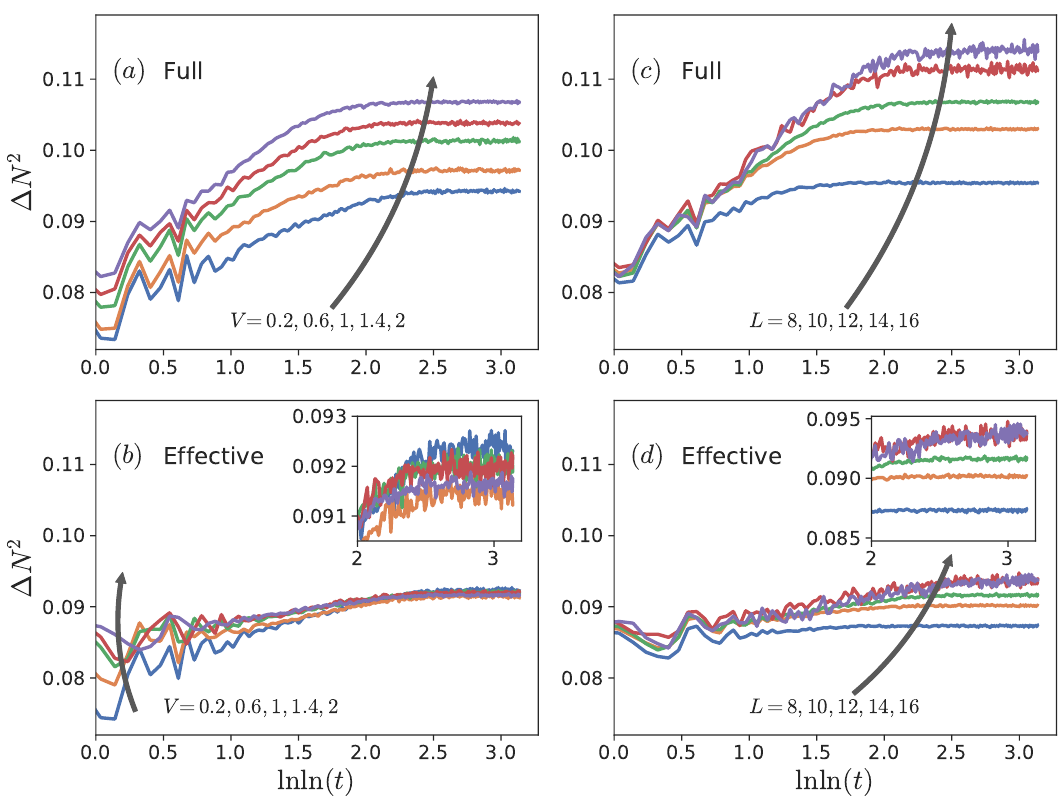
Figure 6: ∆ N 2 ( t ) for the full and effective models for different interaction strength V and system sizes L . For L = 8,10 200000 samples were used, for L = 12 40000 samples, for L = 14 4000 samples, and for L = 16 3000 samples, all with D = 20. The full model is shown in the top row, the effective model in the bottom row. Left column (a, b): dependence on interaction V for L = 12, right column (c, d): dependence on length L for V = 2.0. The insets show a zoom-in into the time frame where ∆ N 2 saturates for the effective